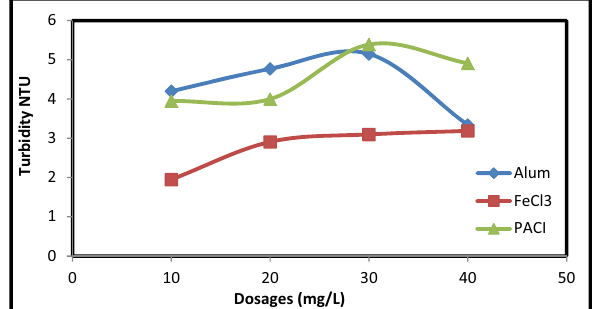
Figure 14: The relation between coagulants and fi nal residual tur - bidity of water sample at 120 cm.